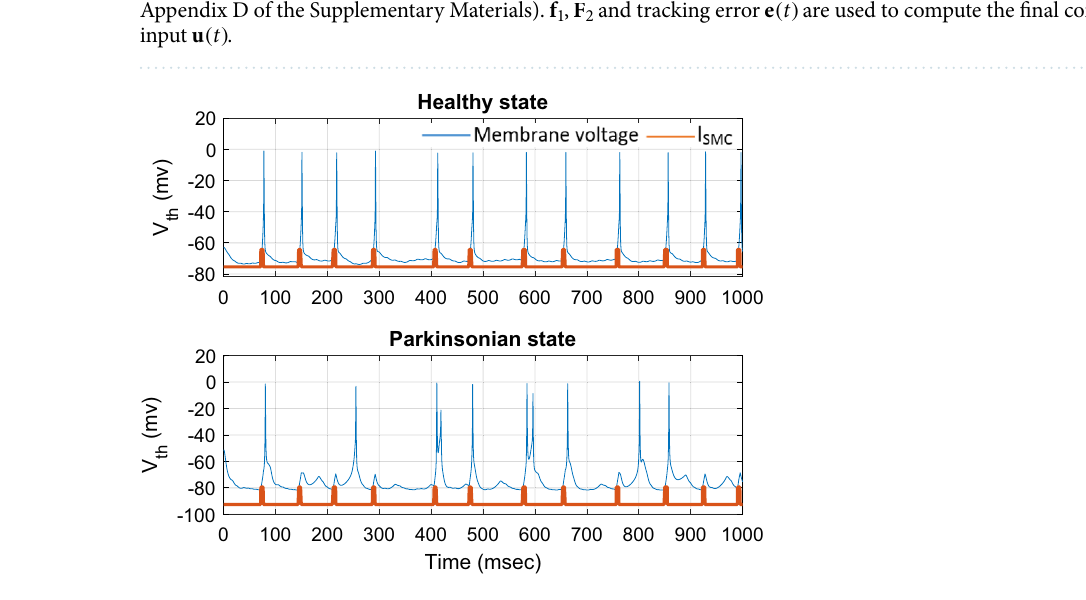
Figure 3. Results of the thalamic firing pattern for neuron 1 in response to the sensorimotor cortex (SMC) excitatory current to the TH for healthy and Parkinsonian states with the different net bias applied currents of Table 1 to the populations of STN , GPe , and GPi